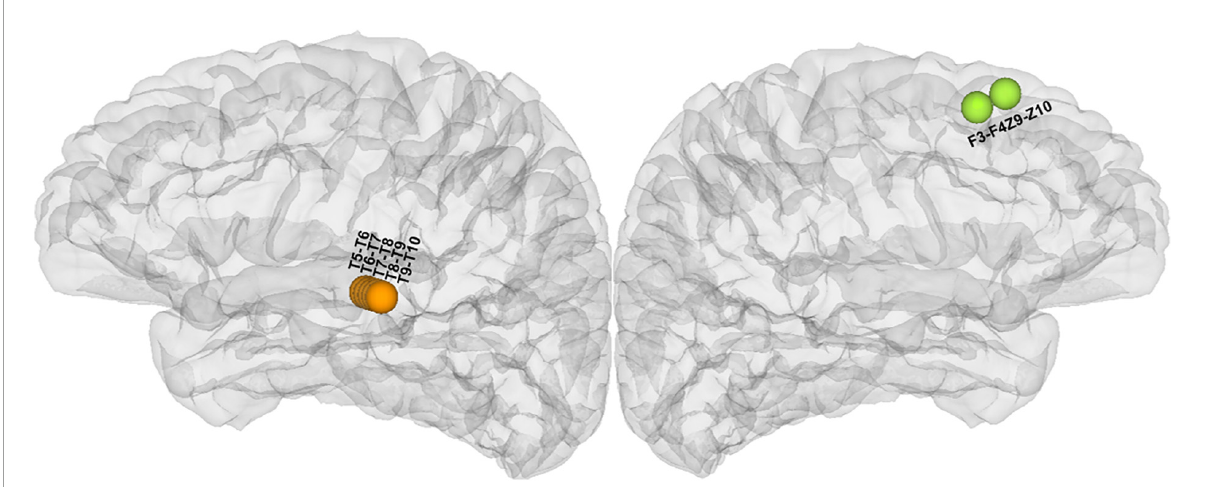
FIGURE2 Anatomical location of all cortical stimulated sites responsible for hallucinations during electrical stimulation mapping (ESM) (the orange electrodes in the lateral view of the left hemisphere were responsible for noise hallucinations and the green electrodes in the medial view of the left hemisphere were responsible for episodic memory